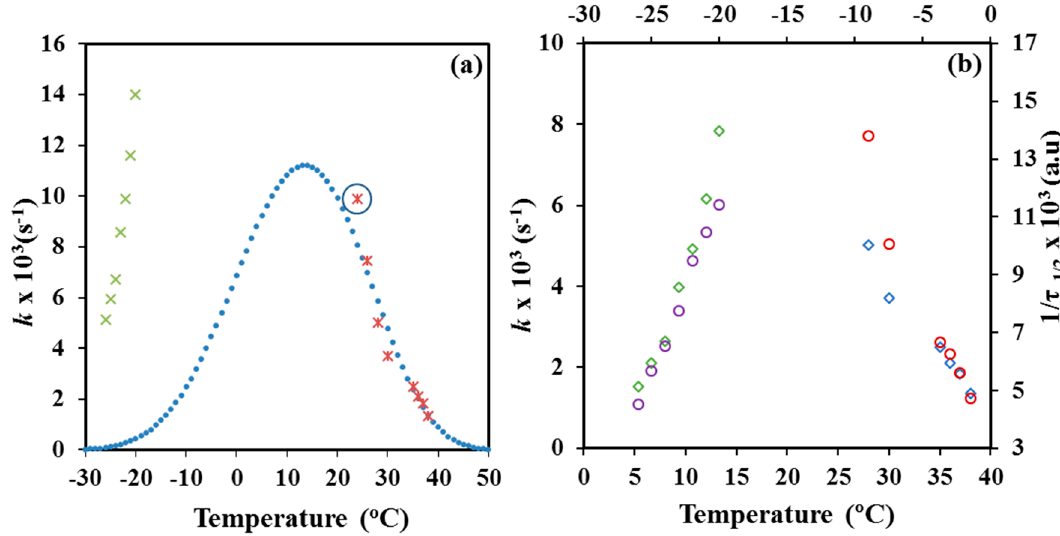
Figure 9. (a ) Experimental ( × ) and simulated ( ● ) temperature dependence of the overall crystallization rate of P4HB for isothermal melt crystallization. For the sake of completeness experimental cold crystallization data are also plotted (×); ( b ) Temperature dependence of the overall crystallization rates ( ♦ , ♦ ) and the reciprocal crystallization half-times ( о , о ) of P4HB for melt and cold